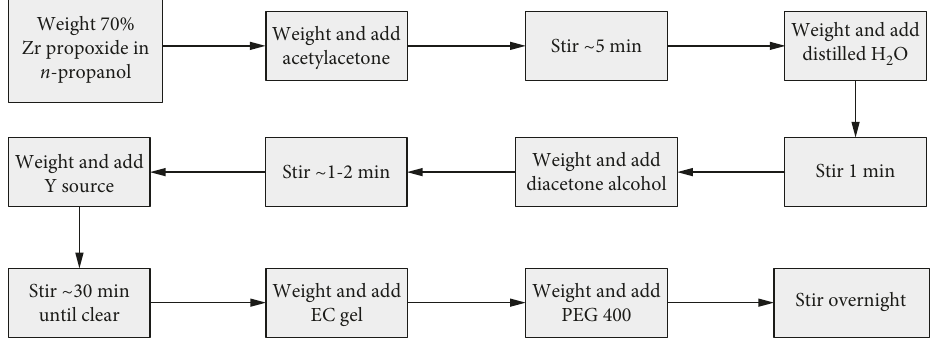
Figure 1: Flowchart for fabricating YSZ paint in the laboratory.